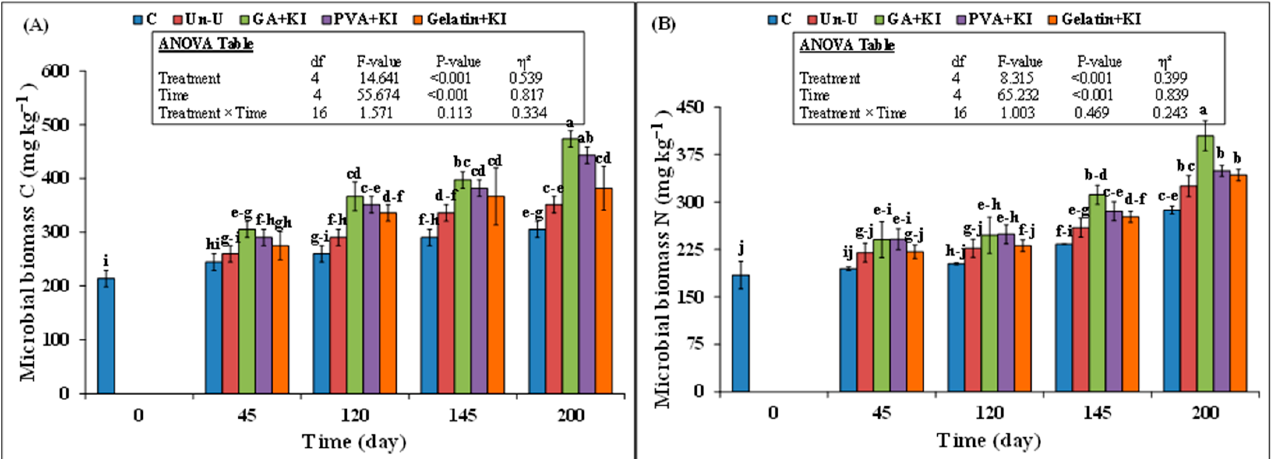
Figure 6. Mean (n = 3) ( A ) Microbial biomass carbon (MBC) and ( B ) nitrogen (MBN) after application of uncoated and coated urea fertilizers at different time intervals during wheat growing season. Abbreviations of fertilizer treatments can be seen in Figure 1. Different capital or small letters illustrate significant differences among treatments at a 5% probability level after the Tukey ‐ HSD test. The inset table represents the outcomes of analysis of the variance (ANOVA).